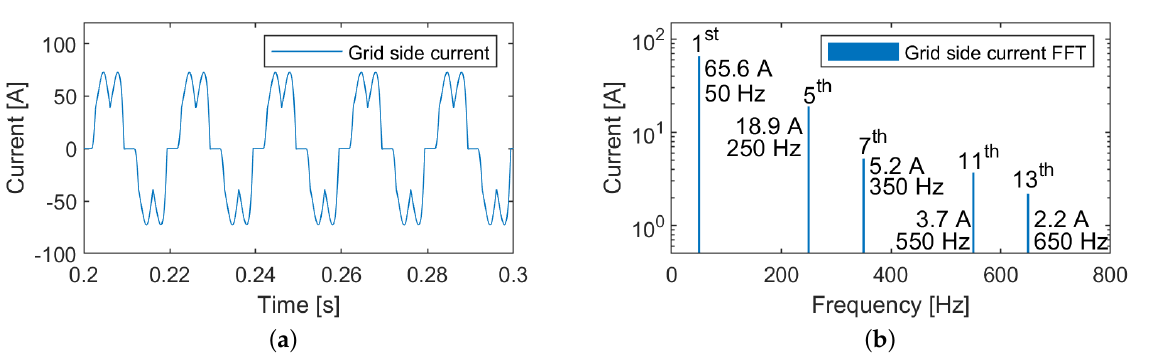
Figure 5. Passive rectifier simulation results. ( a ) Grid side current. ( b ) Grid side current harmonic